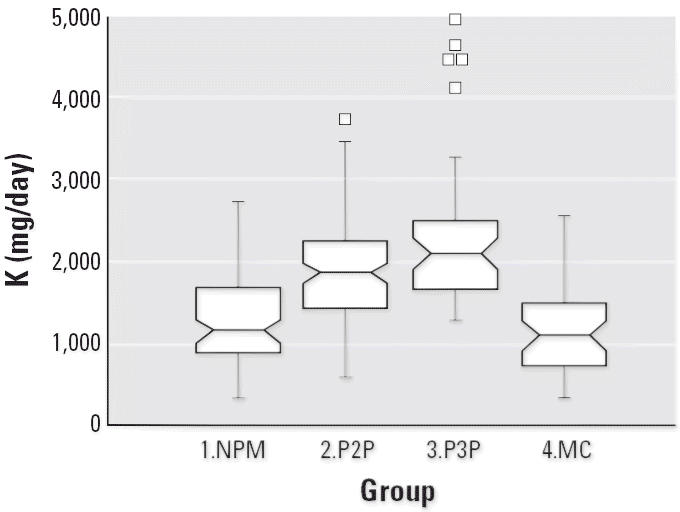
Notched box plot for descriptive statistical data showing daily intakes
of K from 6-day duplicate diets. NHANES III daily intakes for such females
range from 2,300 to 2,580 mg K (Alaimo et al. 1994).